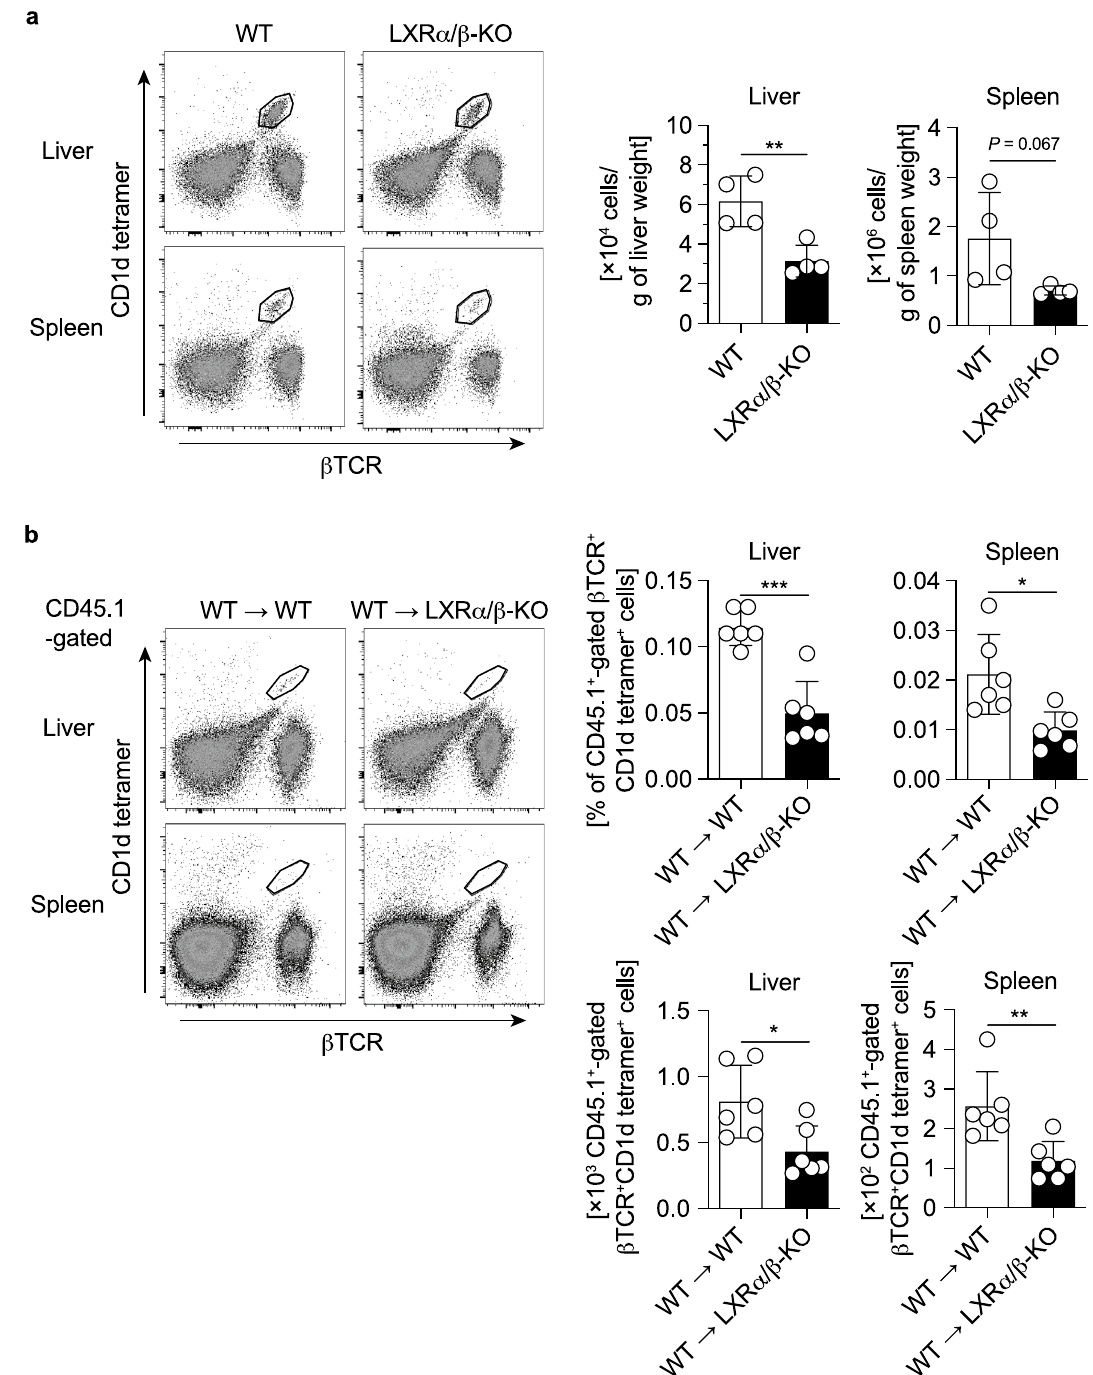
Figure 6. iNKT cells in young mice and bone marrow-transplanted mice. ( a ) The number of iNKT cells in the liver and spleen of young mice. The number of iNKT cells from 4-week-old WT and LXRα/β-KO mice was examined with flow cytometry (n = 4). ( b ) Percentages and numbers of iNKT cells in bone marrow-transplanted mice. Bone marrow cells were isolated from CD45.1 WT mice and transplanted to irradiated CD45.2 WT and CD45.2 LXRα/β-KO mice. After 4 weeks, hepatic MNCs and splenocytes were isolated from recipient WT and LXRα/β-KO mice (n = 6), and analyzed with flow cytometry for iNKT cell populations in CD45.1-gated MNCs. Percentages and cell numbers per tissue weight were shown. * P < 0.05, ** P < 0.01, *** P < 0.001 (Student’s t